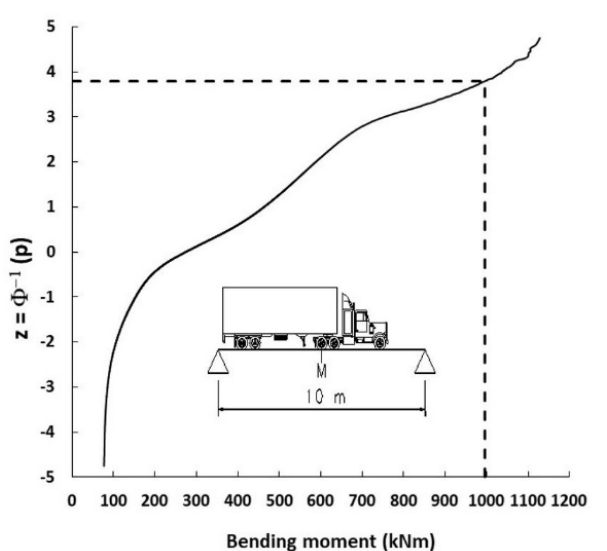
Figure 11. Determination of the load effect on the normal probability